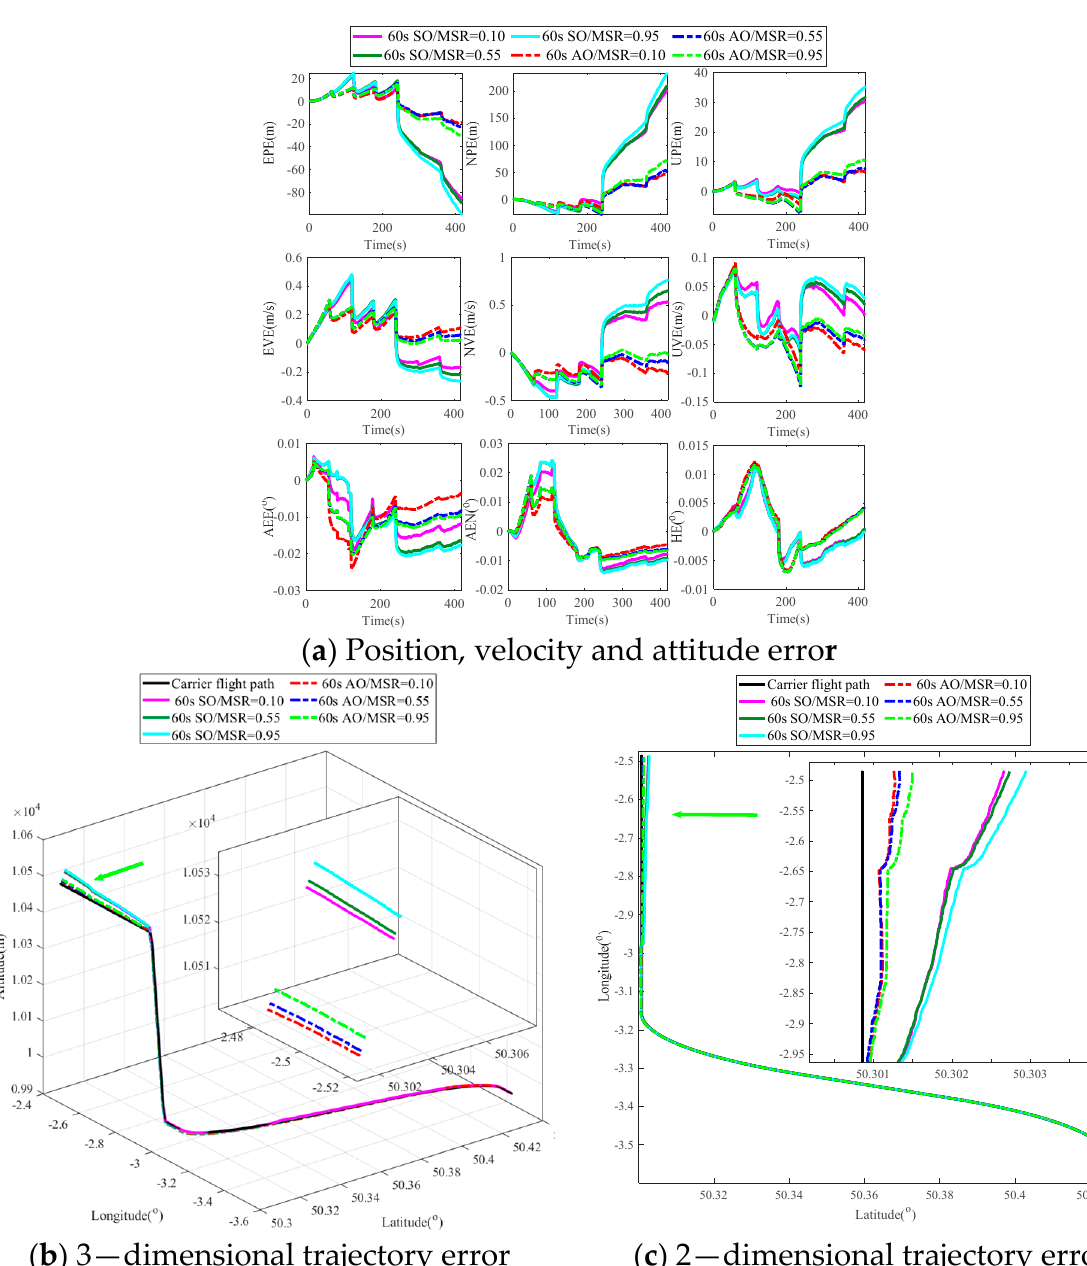
Figure 10. Error under different MSR.